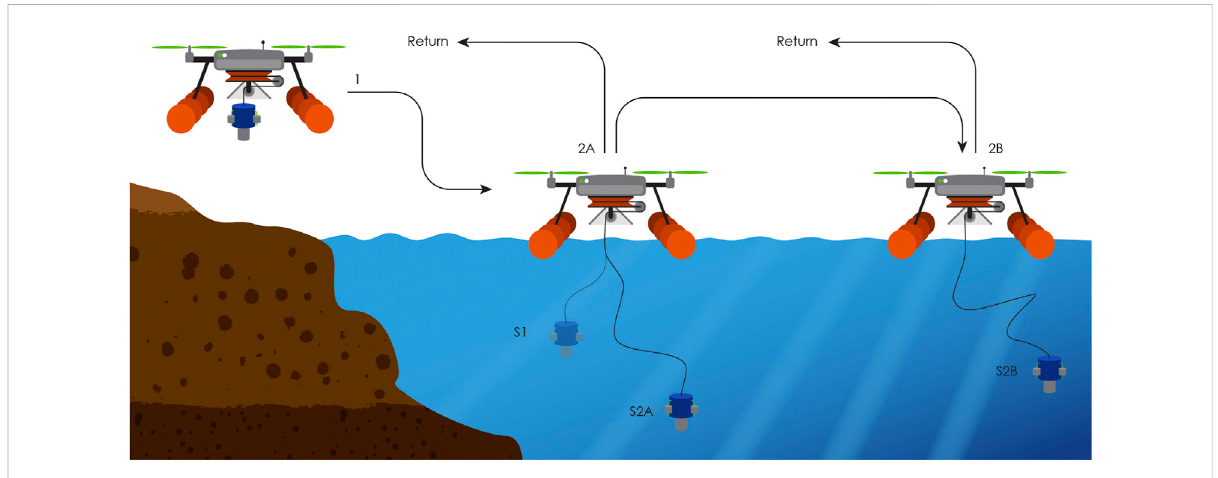
FIGURE 2 Mission pro fi le for theMEDUSA system. Take-off from shore - 1 fl y to aquatic location ofinterest - 2Aland on thewater surface- S1collect fi rst water sample at desired depth - S2A collect second water sample at different depth (OR) 2B fl y to second location of interest and collect second sample S2B- return to shore.